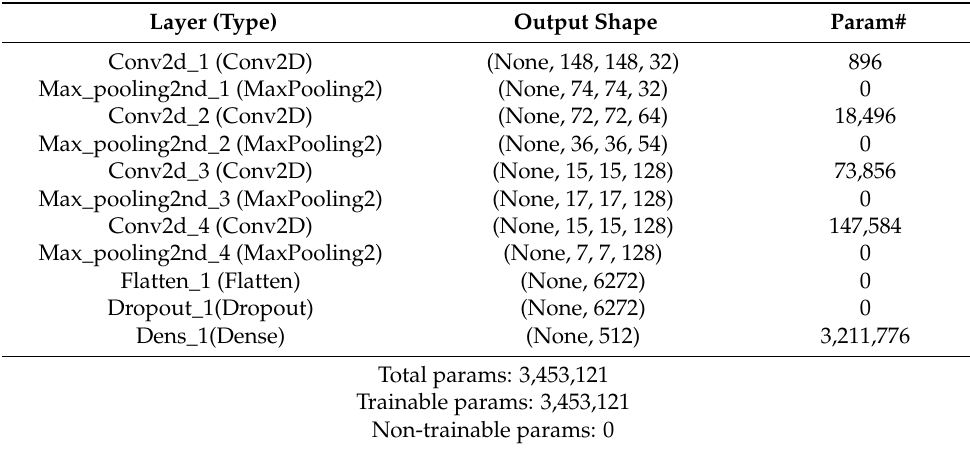
Table 1. The tabular output of our